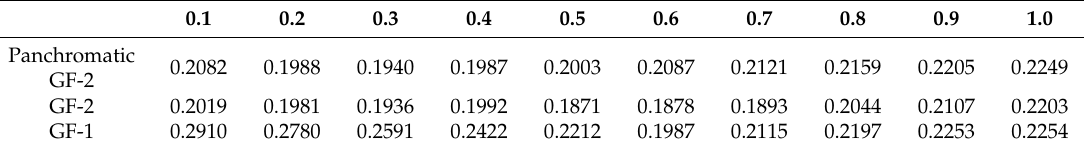
Table 4. Comparison of the RMSE of various high-resolution images at di ff erent